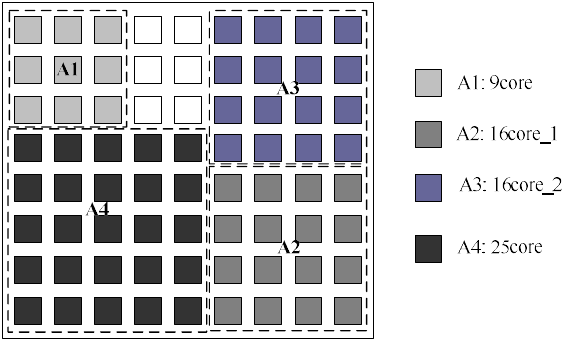
Figure 6. The placement generated by our approach.